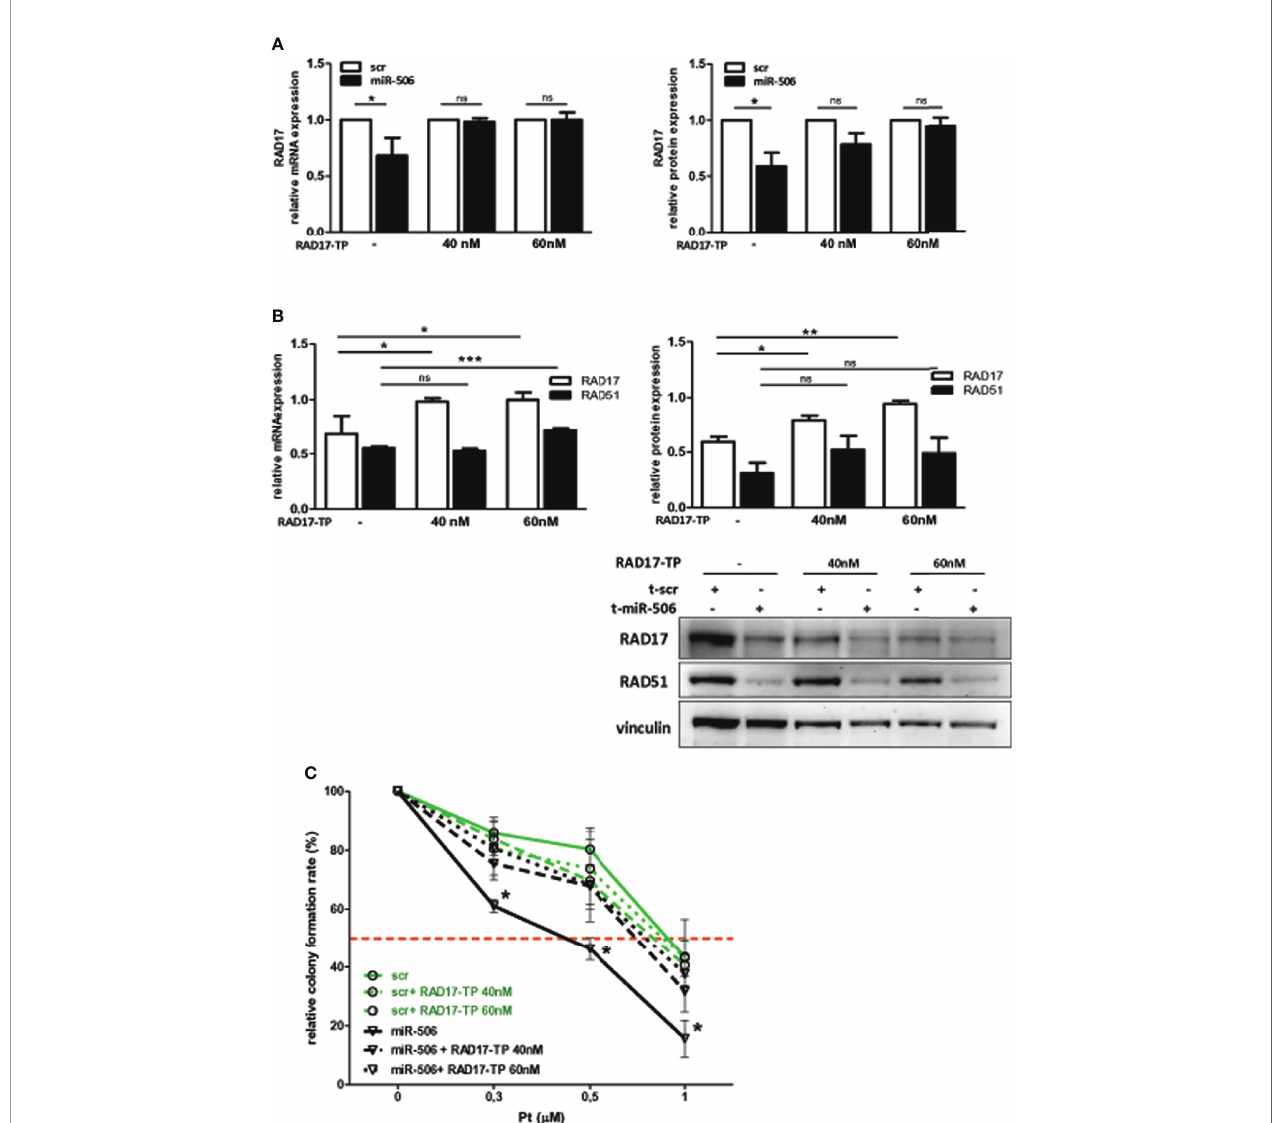
FIGURE 4 | RAD17 regulation directly contributes to Pt-sensitivity mediated by miR-506-3p expression. (A) RAD17 quanti fi cation in t-miR506 and t-scr (control) SKOV3 cells co-transfected with RAD17 target protector (RAD17-TP). Two different concentration of RAD17-TP (40nM and 60nM) were tested. In the left panels is shown RAD17 mRNA relative expression normalized on housekeeping genes and standardized on scr SKOV3 cells, while in the right panel is shown RAD17 protein quanti fi cation normalized to vinculin and standardized on scr SKOV3 cells (Student ’ s t test; *p<0.5; ns = not signi fi cant). (B) Ef fi cacy of miR-506-3p targeting on RAD17 and RAD51 expression in the presence of RAD17-TP. Bars represent relative mRNA expression normalized on housekeeping gene (left panel) and relative protein expression quanti fi ed by western blot assays, normalized to vinculin and standardized on scr SKOV3 cells(upper panel). Student ’ s t-test was used (*p<0.5; **p<0.01; *** p<0.001; ns = not signi fi cant); lower right panel: representative western blot. (C) Percentage of relative colony formation rate following Pt treatment. SKOV3 cells were transfected with miR-506-3p (black lines) or scrambled miR (green lines) alone (solid lines) or each co-transfected with two doses of RAD17-TP (40nM dashed lines, 60 nM dotted lines) and then left untreated or treated with Pt at the indicated doses. Data are mean ± SD of two independent experiments, 6 replicates each. Two way ANOVA and Bonferroni ’ s post test was used to compare t- miR-506-3p versus t-miR-506-3p + 40/60nM RAD17-TP SKOV3 cells (*